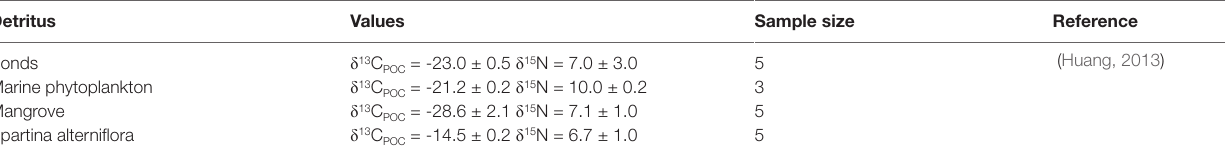
TABLE 1 | Signatures of δ 13 C POC and δ 15 N of organic detritus.